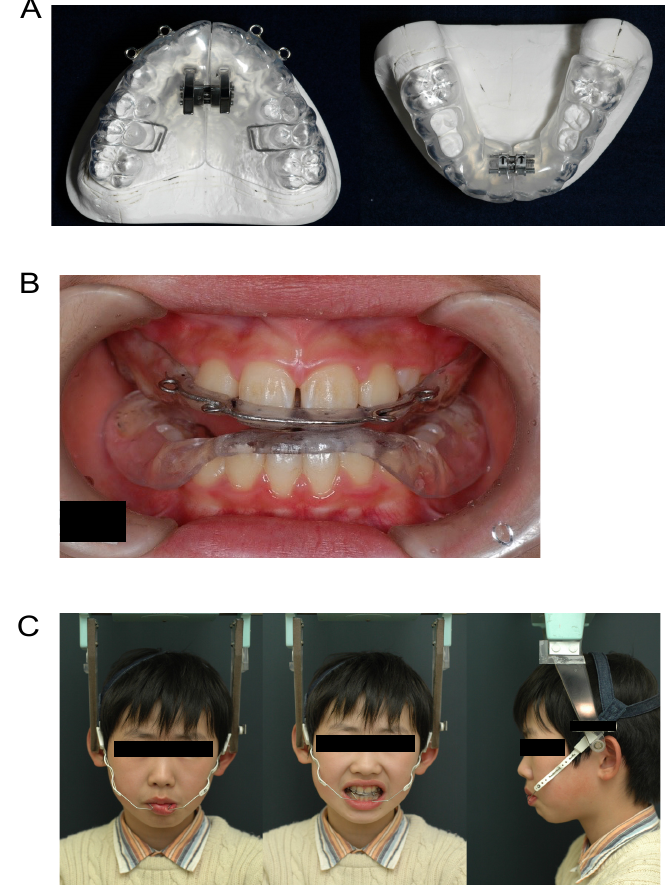
Figure 1. Combined use of SBJA and high-pull J-hook headgear. SBJA with loop attached to the labial side of maxillary anterior teeth ( A ); intra-oral photograph while wearing SBJA ( B ); facial photograph while wearing SBJA and high-pull J-hook headgear ( C ).